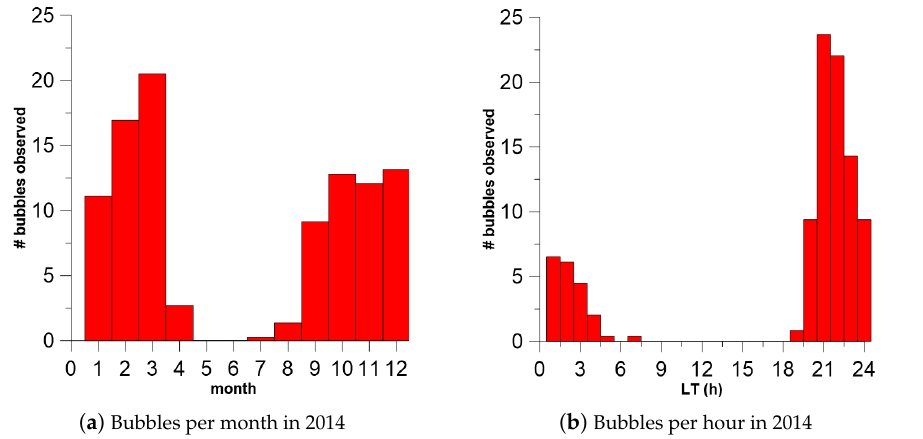
Figure 9. Aggregated number of bubbles analyzed in the Canary Islands (Spain—mas1 (27.61 ◦ N, 15.63 ◦ W)): ( a ) bubbles observed monthly in 2014 and ( b ) bubbles observed hourly in